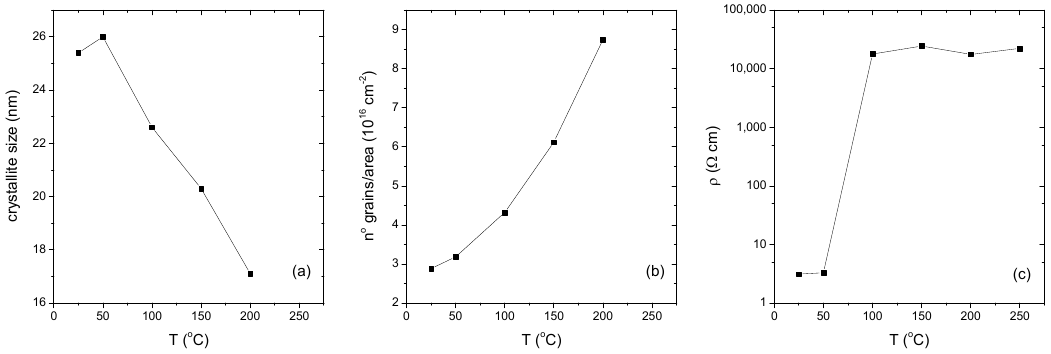
Figure 4. Structural and electrical properties of the CdS thin films as a function of substrate temperature. ( a ) Grain size; ( b ) number of grains per unit area; ( c ) electrical resistivity. Solid lines are a guide for the eye.